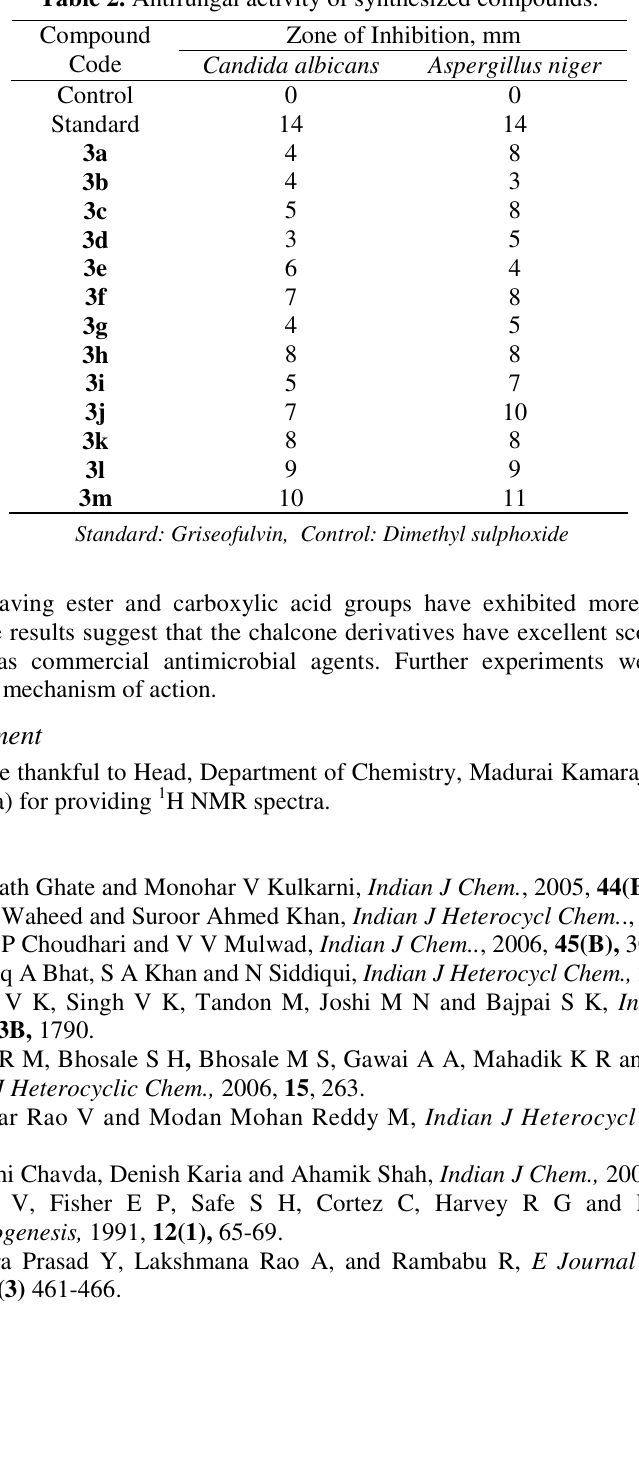
Table 2. Antifungal activity of synthesized compounds. Zone of Inhibition, mm Compound Code Candida albicans Aspergillus niger Control 0 0 Standard 14 14 3a 4 8 3b 3c 3d